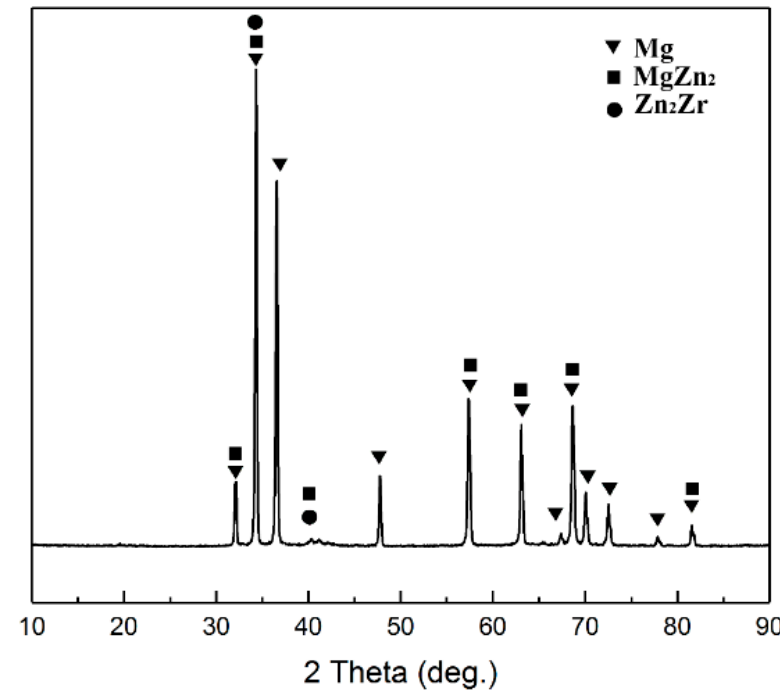
Materials 2022 , 15 , x FOR PEER REVIEW Figure 9. X-ray diffraction pattern before and after 50 h of creep at 150 ◦ C under 100 MPa stress. Figure 9. X-ray diffraction pattern before and after 50 h of creep at 150 °C under 100 MPa stress.